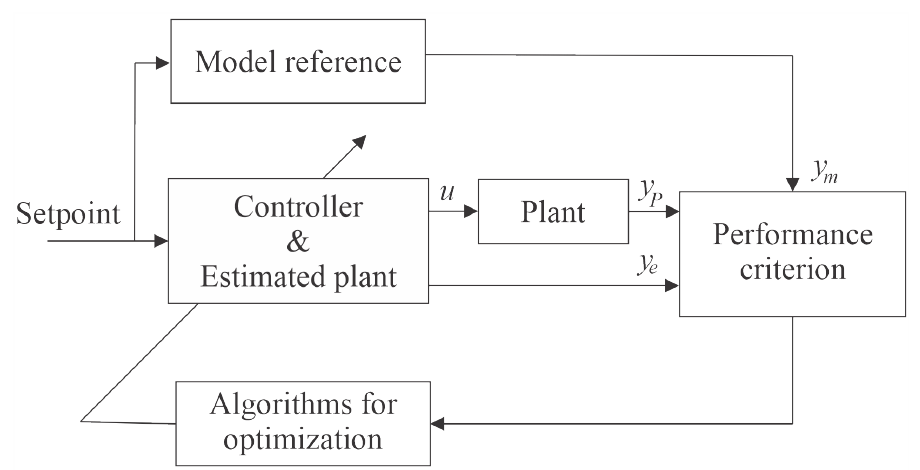
Figure 3. Indirect adaptive control by reference